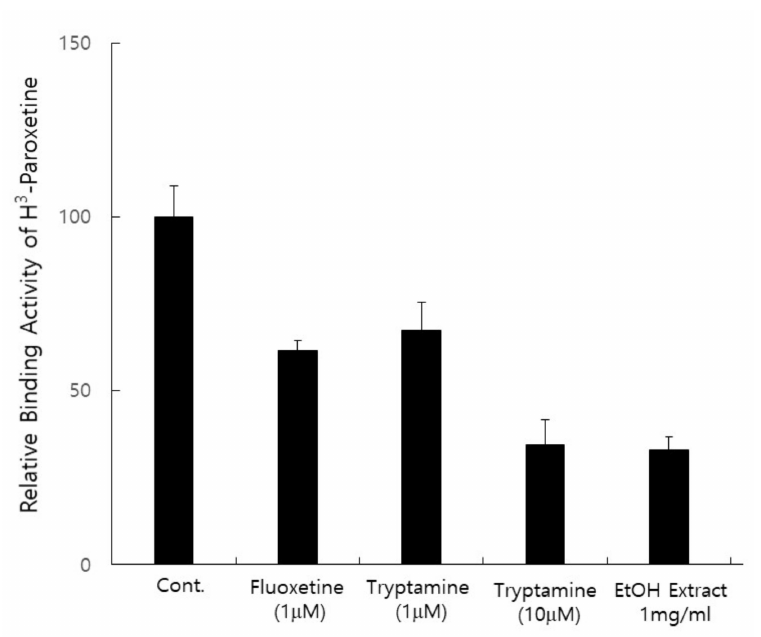
Figure 4. Extract of P. eryngii showed inhibition activity of serotonin receptor binding. The serotonin receptor binding assay was performed with an ethanol extract of P. eryngii to identify the neurotransmitter activity of the extract of P. eryngii. A 1 mg/mL concentration of P. eryngii extract was added to the reaction mixture of the serotonin receptor binding assay, and the inhibition rate of paroxetine-H 3 binding to the human 5HT1-A protein was investigated. The positive control was 1 mM of fluoxetine (Prozac. Sigma–Aldrich, St. Louis, MO, USA), and tryptamine was also used to compare the activity with the extract of P. eryngii